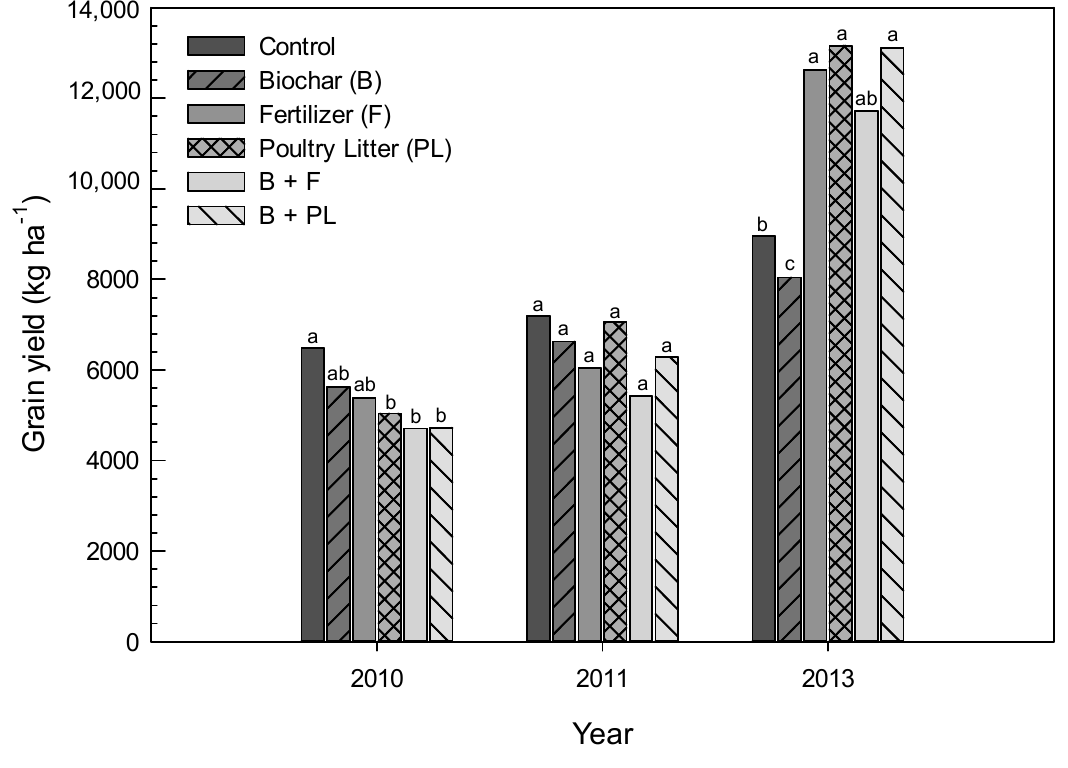
Figure 3. Effect of biochar, poultry litter, chemical fertilizer, and the combined treatments tested on corn dry matter yield in 2010, 2011, and 2013 growing seasons. Within each year, values followed by the same letters are not significantly different according to Fisher’s LSD (0.05) level.